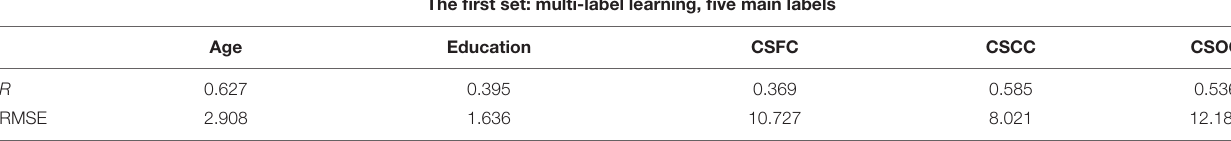
TABLE 2 | Performances of PLSR in the four sets of estimations. The first set: multi-label learning, five main labels